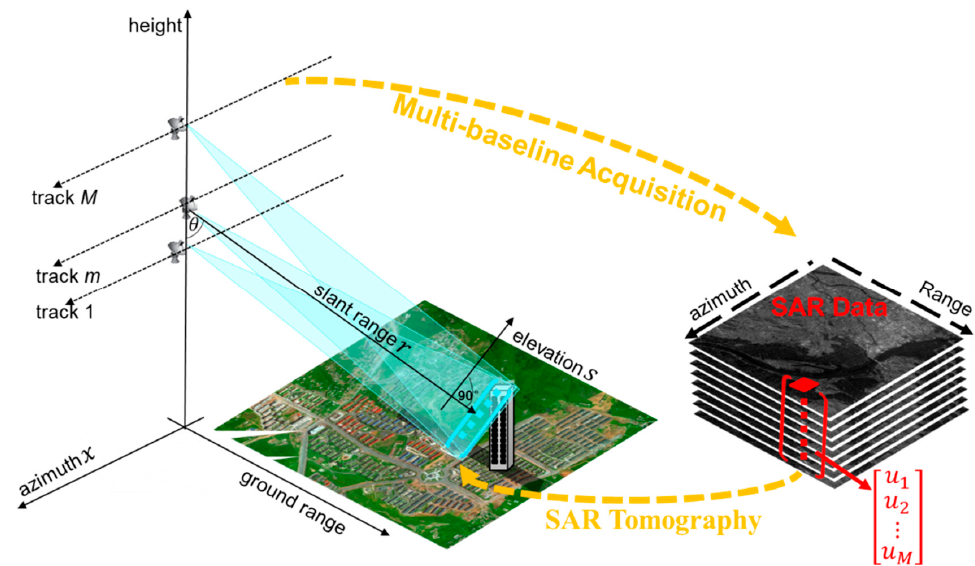
Figure 1. One-dimensional (1D) synthetic aperture radar tomography (TomoSAR) model.